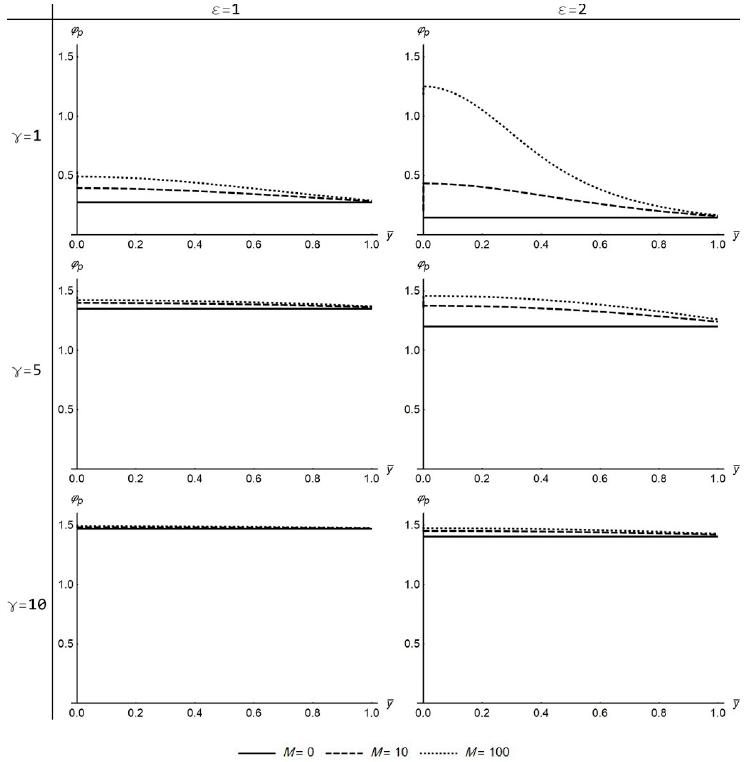
Figure 15. The profiles of 𝜑 (cid:3043) for different values of the 𝜀 , 𝛾, and 𝑀 parameters (parallel case).